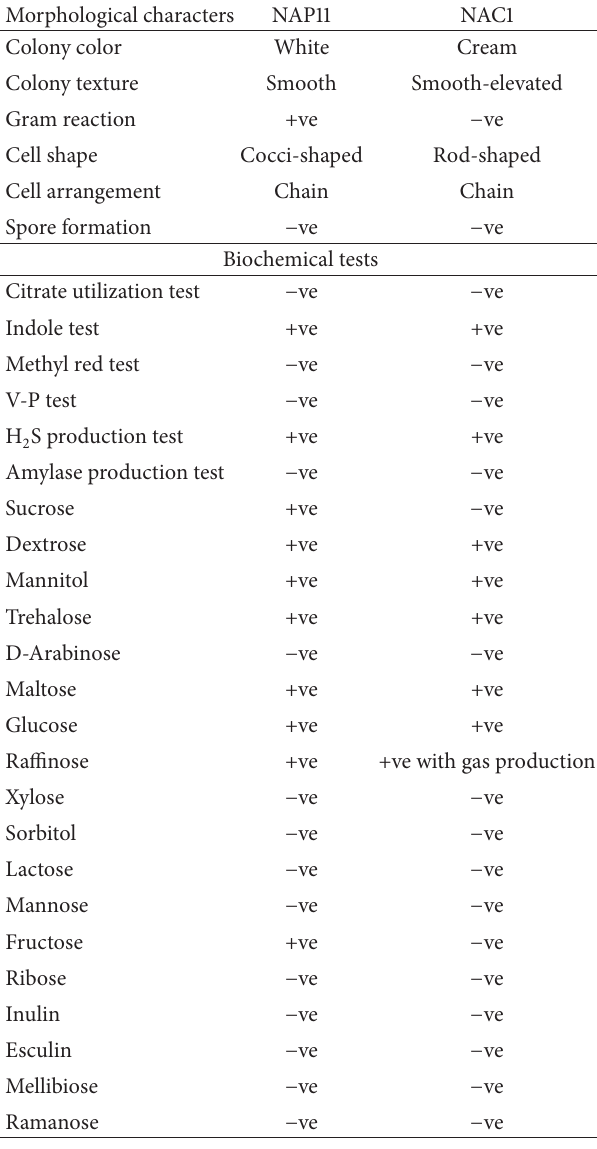
Table 2: Morphological and biochemical characters of selected isolates.